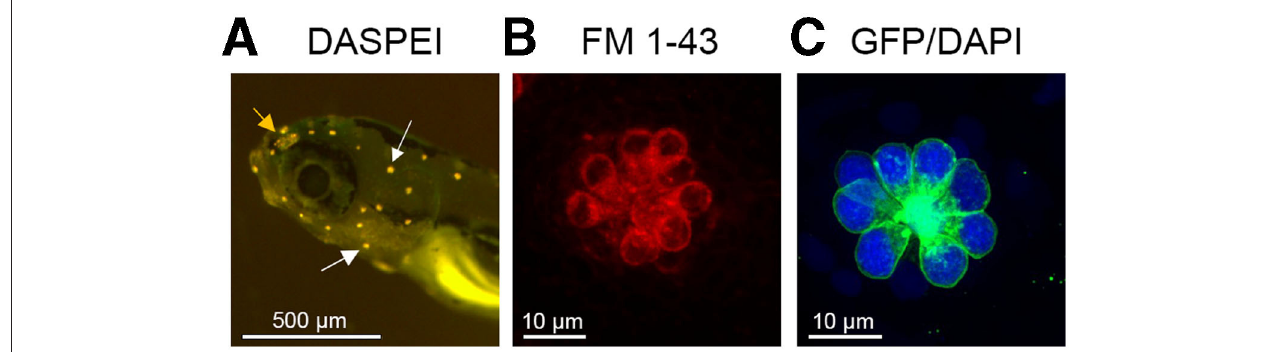
FIGURE 1 | Lateral line visualization using fluorescent markers. (A) Larval zebrafish head showing labeling with the vital dye DASPEI. White arrows denote examples of labeled neuromasts. The orange arrow shows the olfactory epithelium, which also labels with DASPEI. (B) A single neuromast labeled with the vital dye FM 1–43, that enters hair cells through the MET channel. (C) A single neuromast from a Brn3c:mGFP transgenic zebrafish, where hair cells express membrane-bound GFP (green). This fish was also live incubated with DAPI (blue) to selectively label hair cell